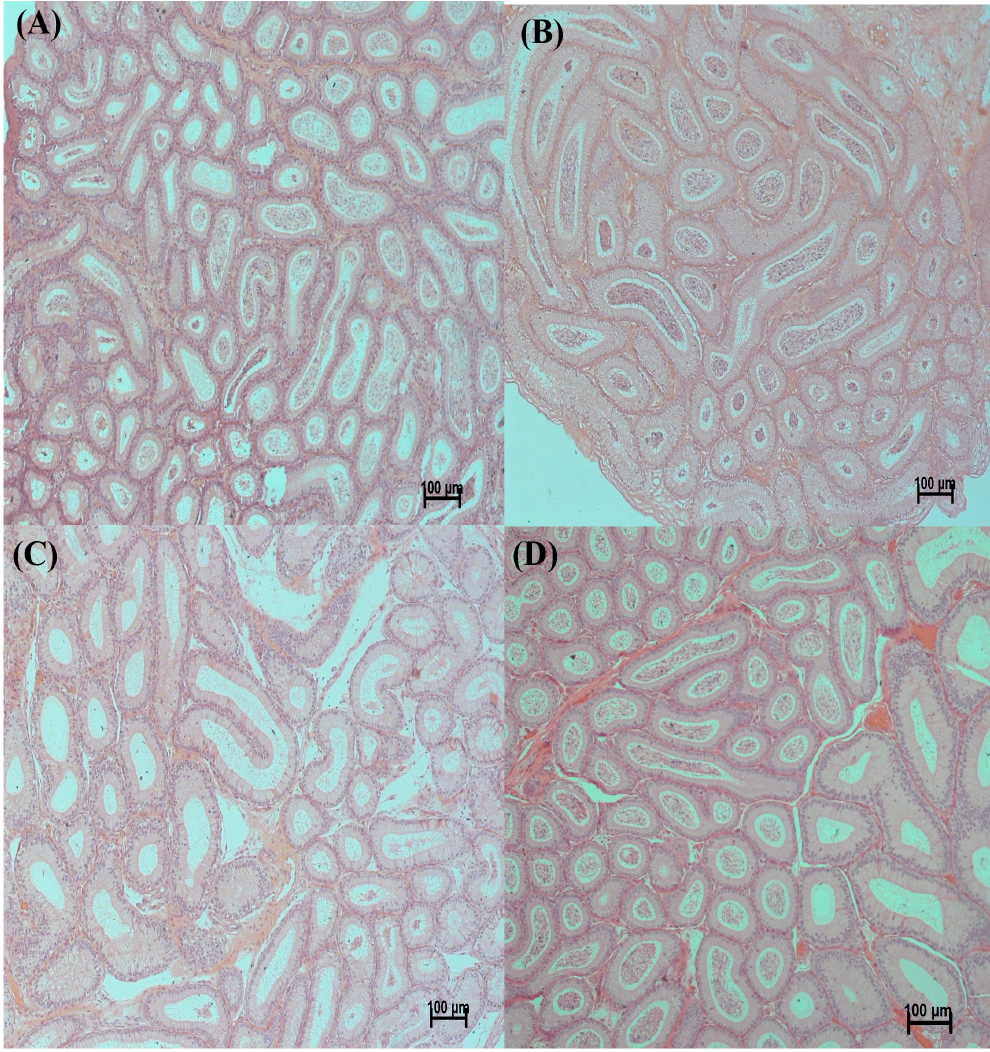
Figure 2. Epididymis histology. ( A , B ) Control and PU groups show maximum number of sperms in epididymis; ( C ) LA-induced OS proved damage to sperms as the epididymis shows reduction of sperm count; ( D ) PU + LA co-administration presented increase in number of sperms in epididymis